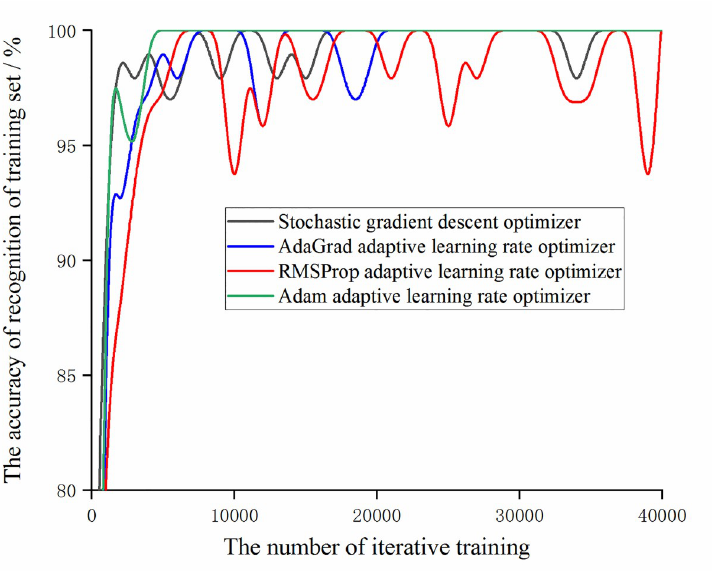
Fig 13. The trend of the accuracy of the training set and validation set with the number of iterative training under different optimizers.